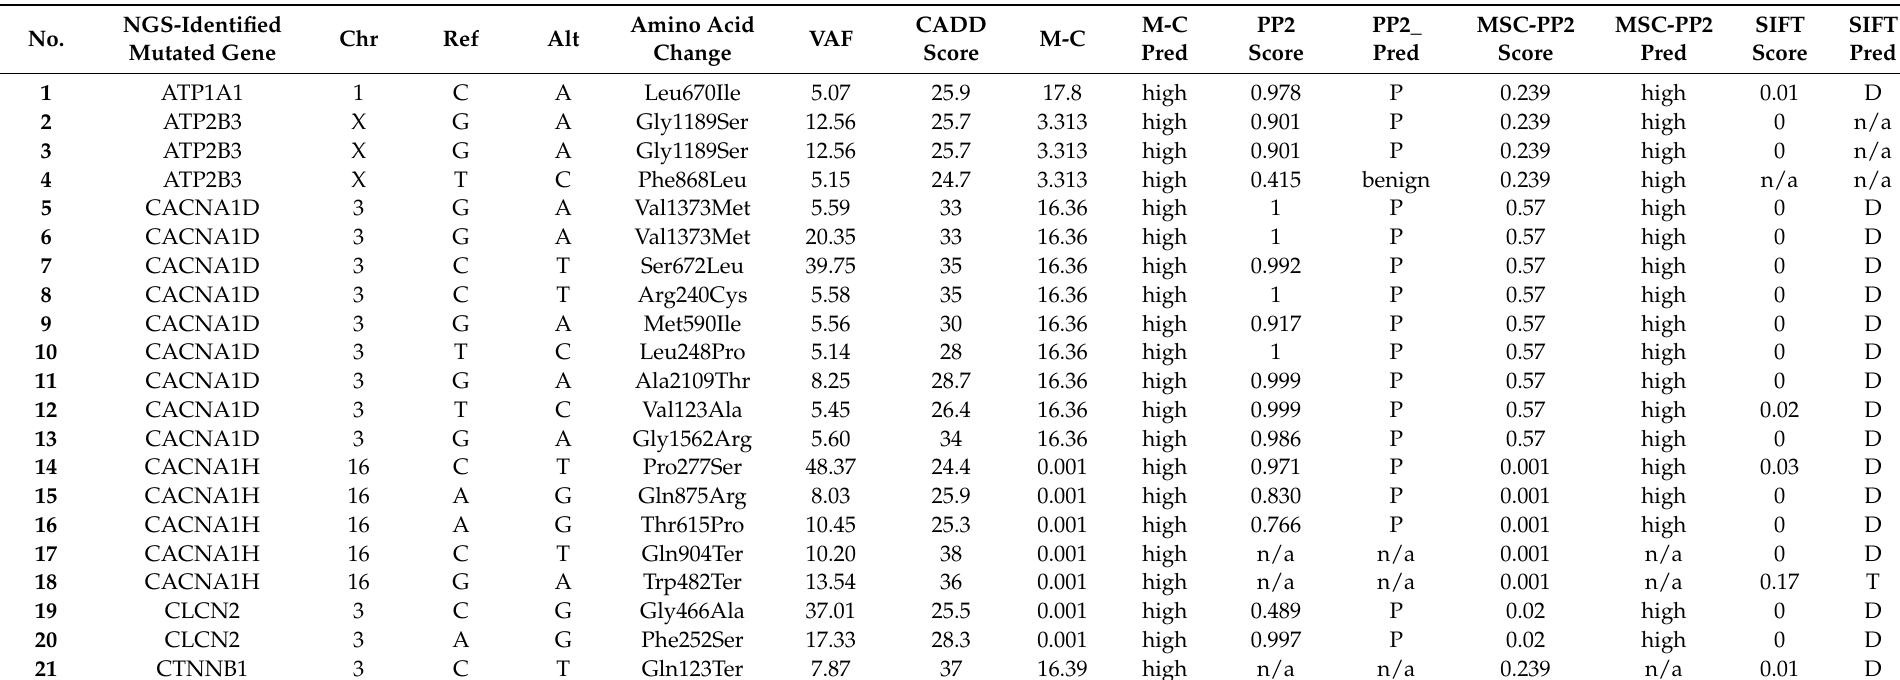
Table 1. Somatic mutations identified in unilateral primary aldosteronism by customized targeted next-generation